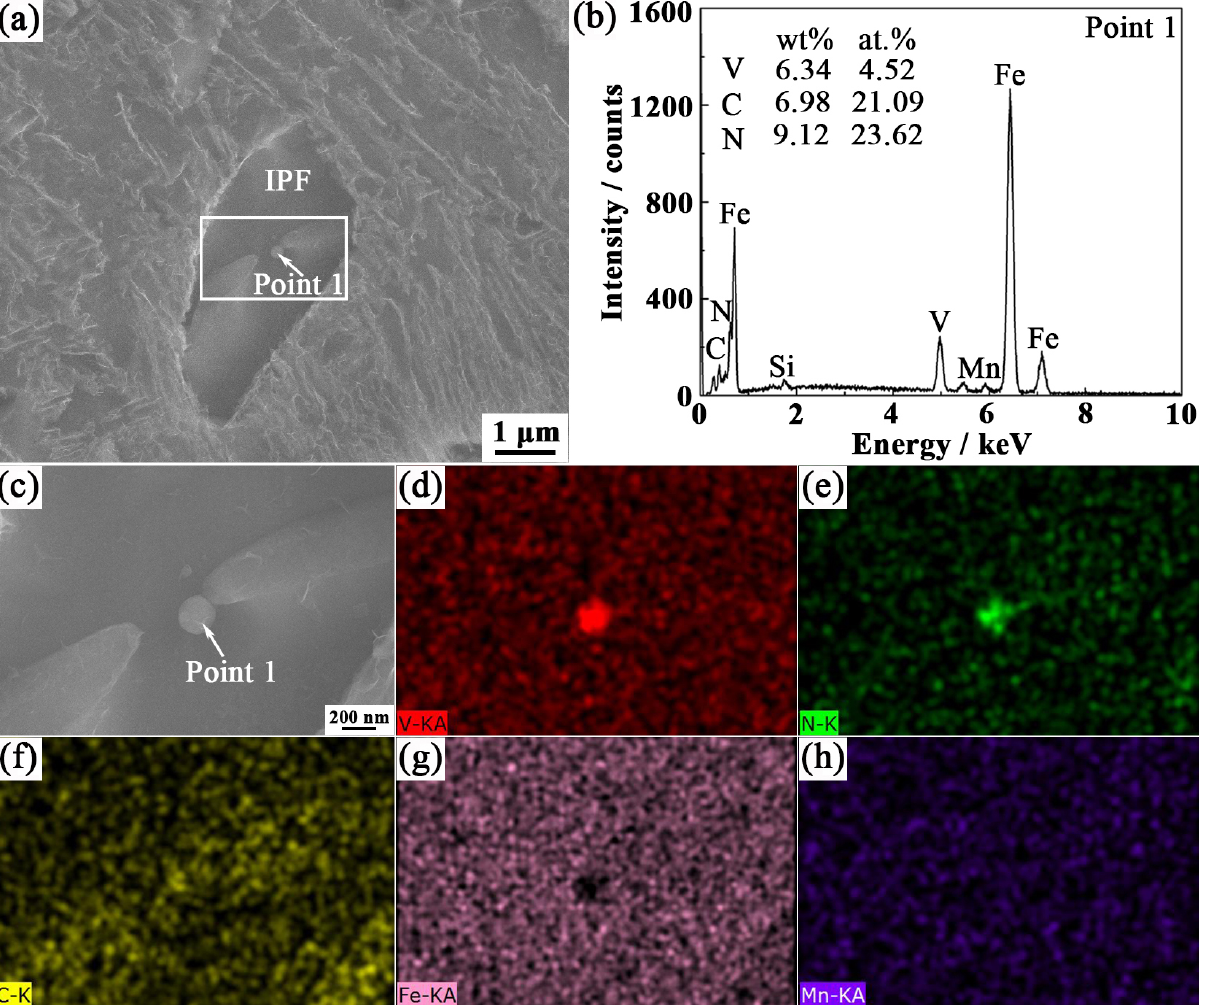
Figure 11: SEM characterization of the typical IPF and its nucleus in the simulated CGHAZ: (a) SEM image; (b) EDS spectrum; (c) magnifica- tion of marked zone in the frame; (d)-(h) EDS mapping analysis of V, N, C, Fe and Mn.